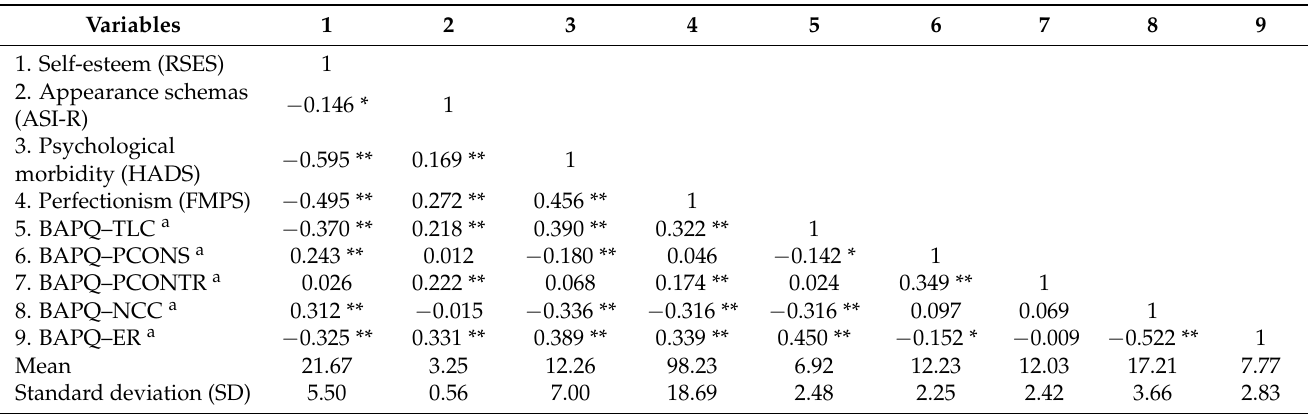
Table 4. Correlations between psychological variables and self-esteem.